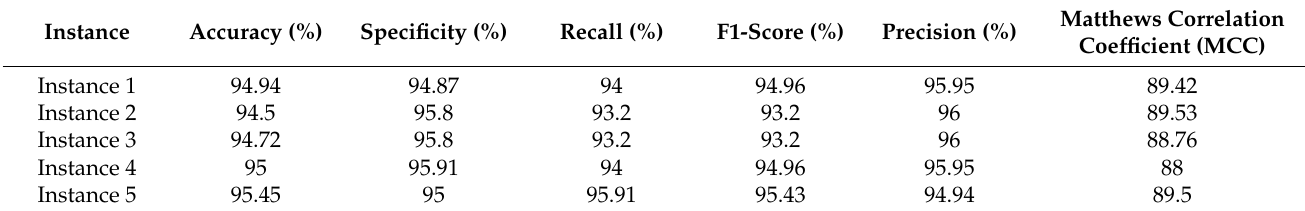
Table 3. Model evaluation results.